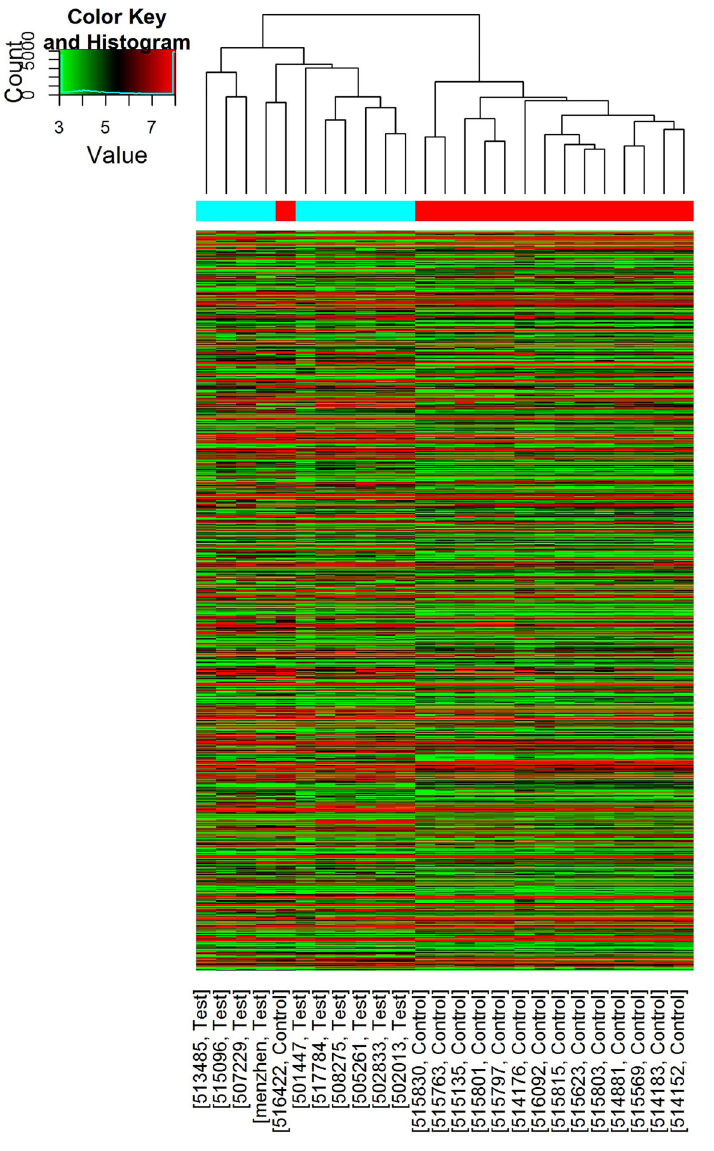
Figure 1. Hierarchical clustering showing mRNA expression pro fi le between the two groups and homogeneity within each group (blue: pancreati- cobiliary maljunction (PBM); red: control). Red and green represent up-regulated and down-regulated genes in the PBM